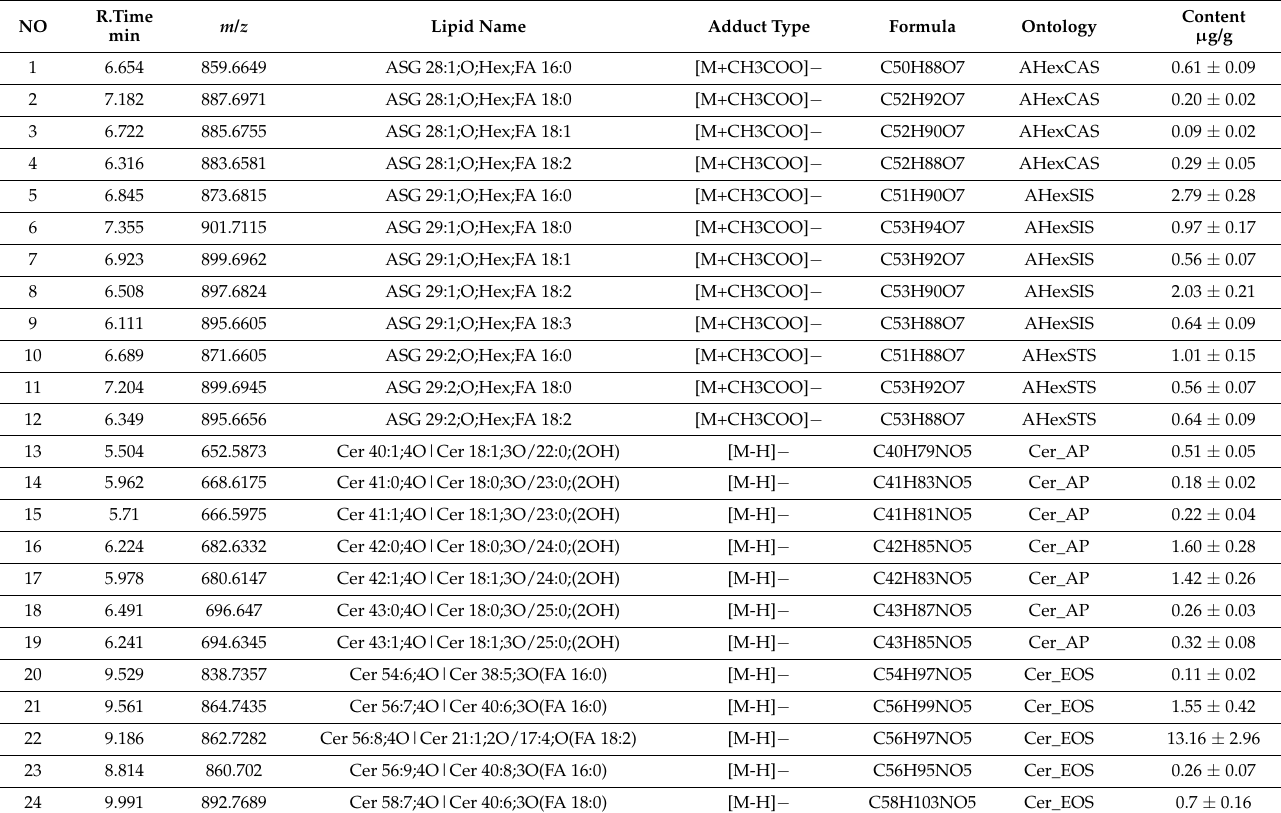
Table 1. Composition of the 214 lipids in green coffee.